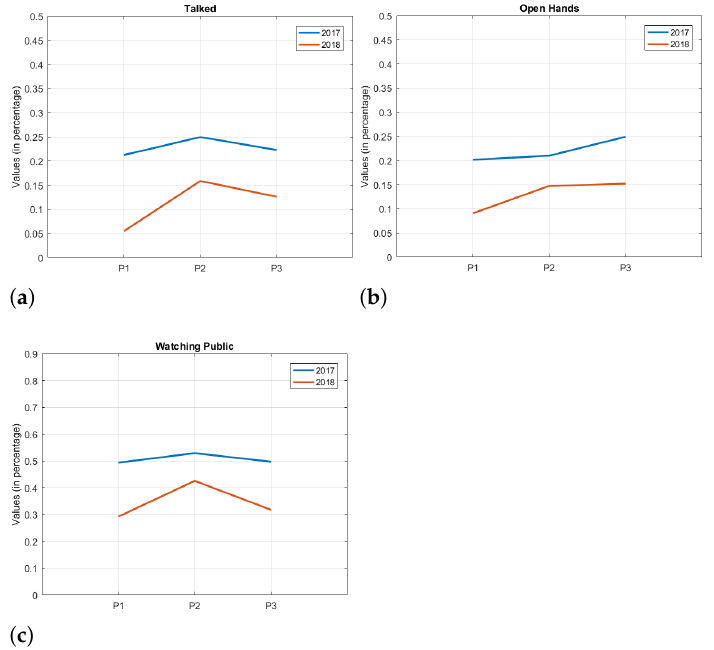
Figure 4. Trend charts comparing years. ( a ) Talked, ( b ) OpenHands, ( c ) Watching